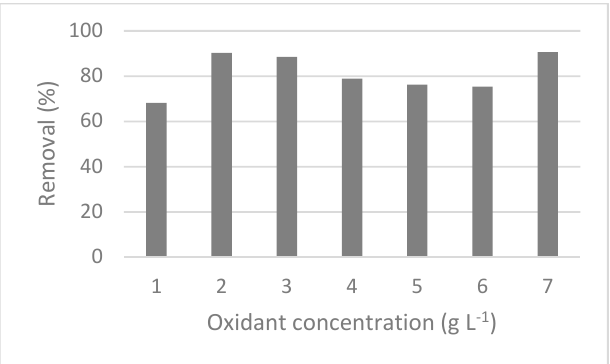
Figure 3. Effect of hydrogen peroxide oxidation on the removal of